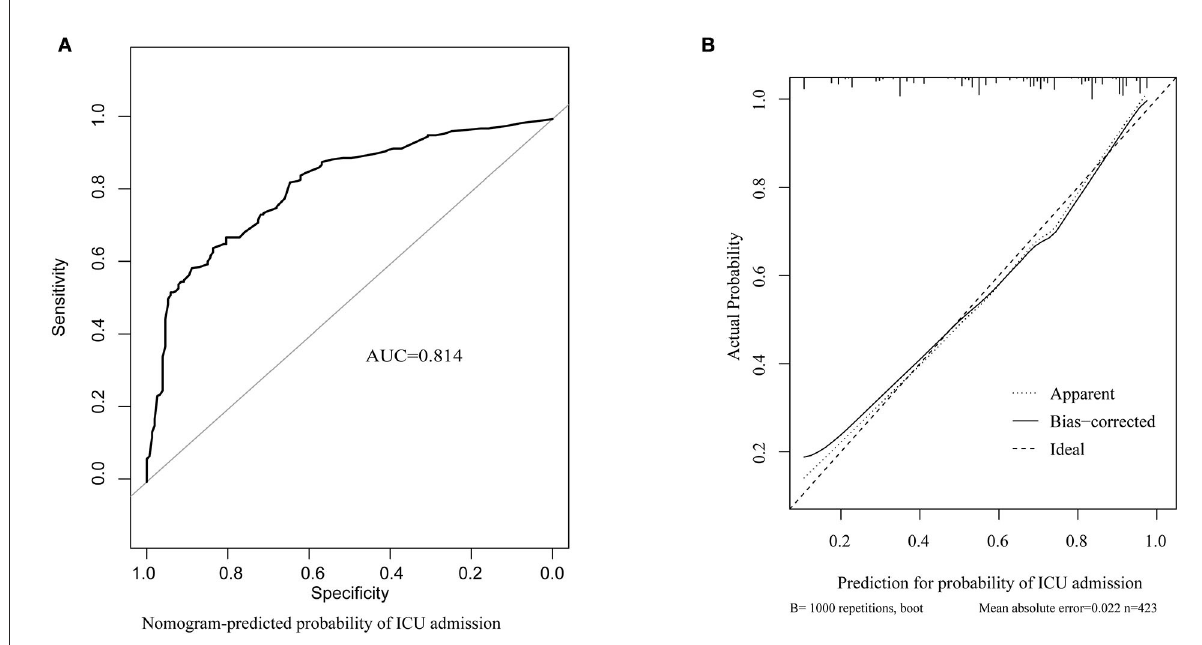
FIGURE5 Predictive power assessment of the tool for predicting ICU admission in the validation. (A) ROC curve and AUC of predicting ICU admission. (B) calibration curves for predicting the probability of ICU admission. The dotted line represents a perfect prediction by an ideal model, and the solid line represents the performance of the nomogram in the validation. ICU, intensive care unit; ROC, receiver operating characteristic; AUC, area under